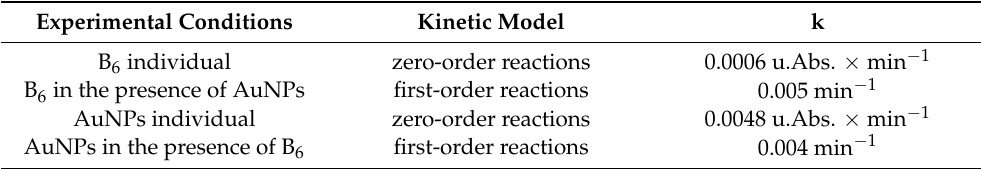
Figure 4. The kinetic models of the zero- and first-order reactions applied for B 6 ( a ) and gold nanoparticles ( b ) electrochemical degradations. Table 1. Kinetic parameters for B 6 and AuNP electrochemical degradation, individual and mixed.